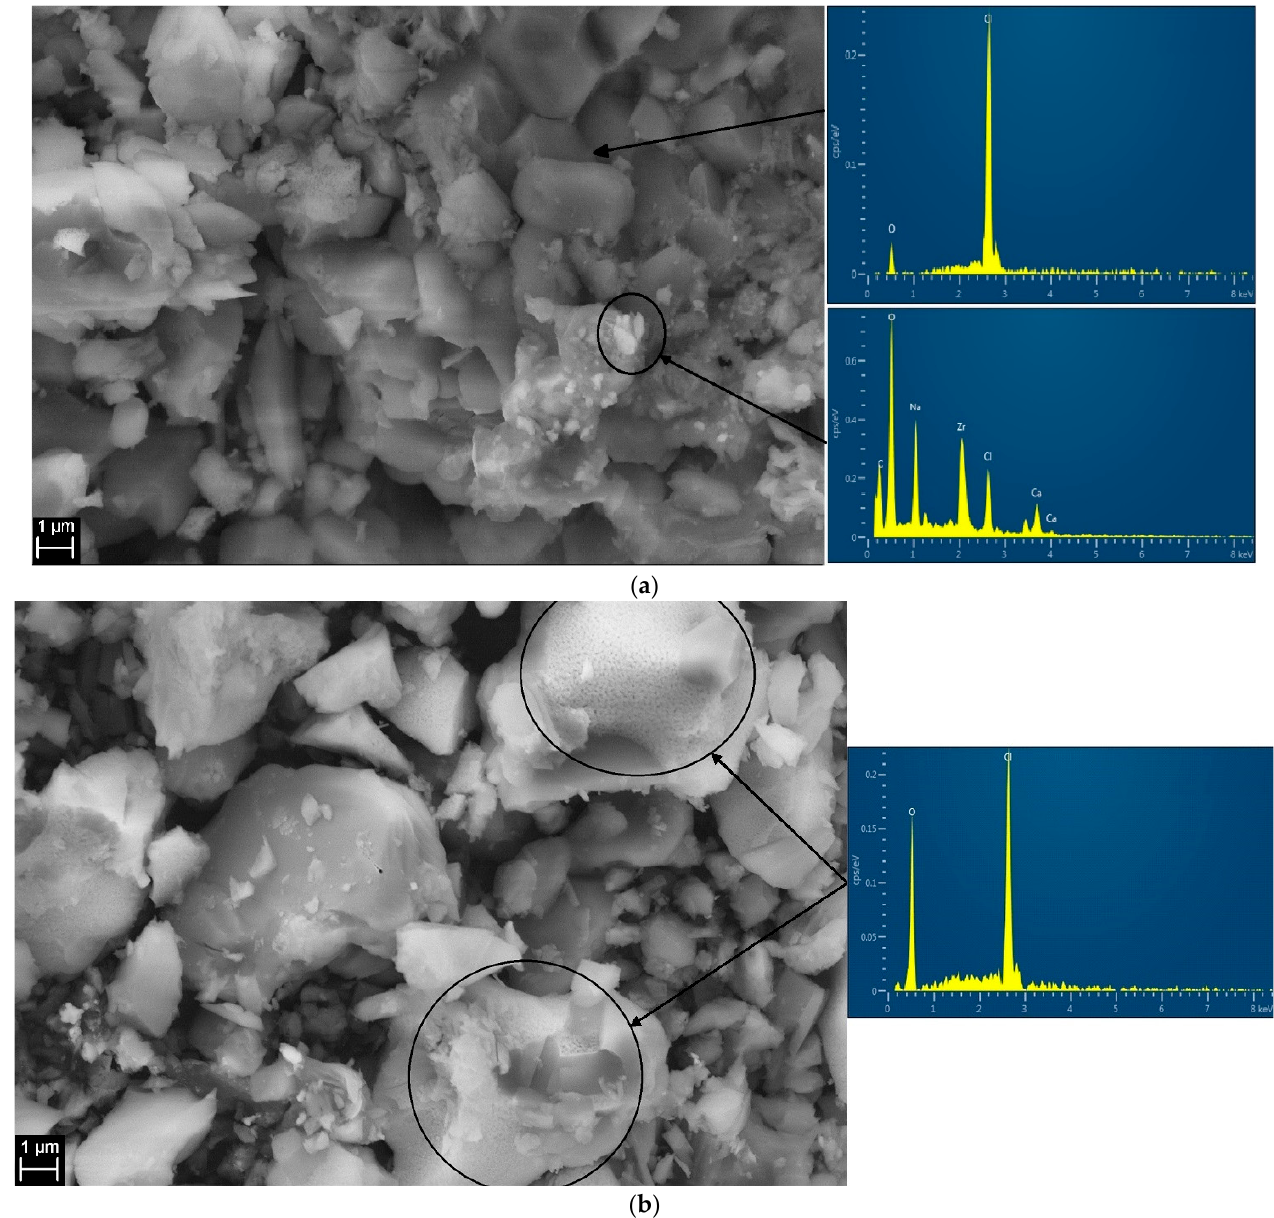
Figure 9. ( a ) SEM/EDS of 32 mol% LiCl-68 mol% LiOH as prepared with zero thermal cycles. ( b) SEM/EDS of 32 mol% LiCl-68 mol% LiOH decomposed at 700 °C.